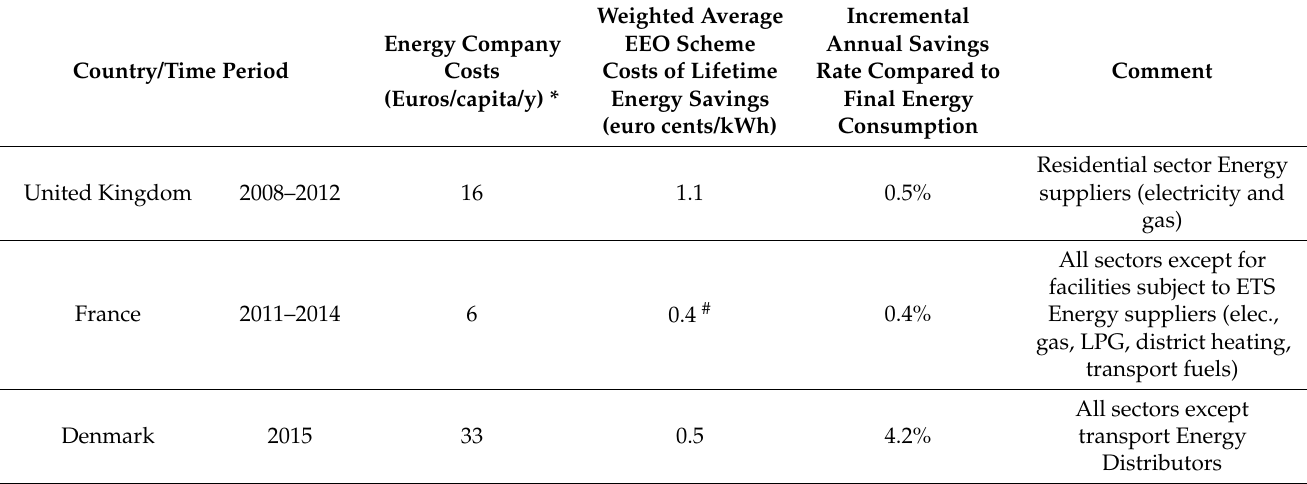
Table A1. Performance Indicators of Energy Efficiency Obligation (EEO) Schemes in five EU Countries (and Vermont and California for